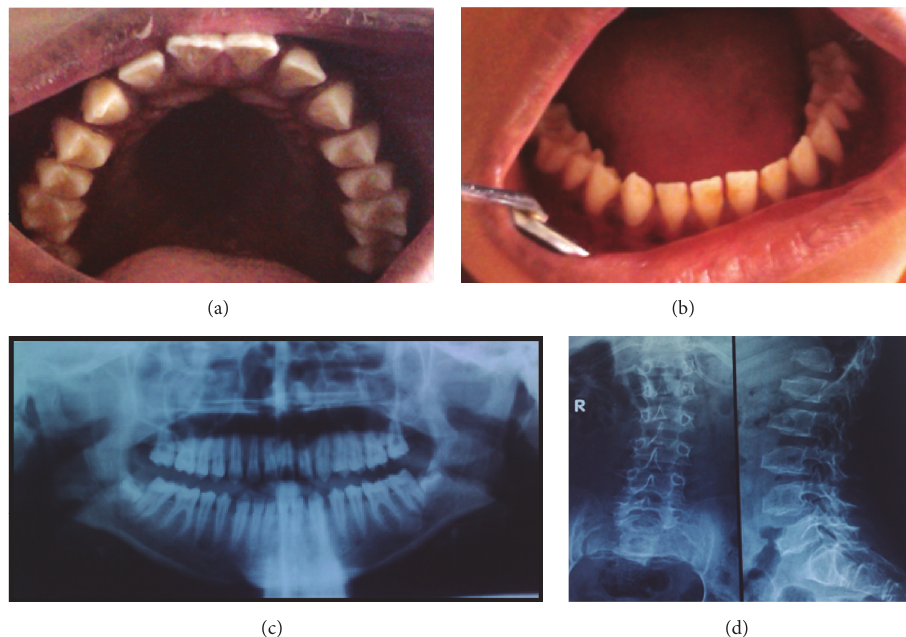
Figure 1: (a), (b) Spade-shaped incisors, pointed cusps, and spacing between teeth in case 1 . (c) Orthopantomograph showing thin enamel with normal radio density. (d) Spinal radiographs revealing kyphoscoliosis and tongue-like projections from anterior surface of vertebral bodies in case 1 .